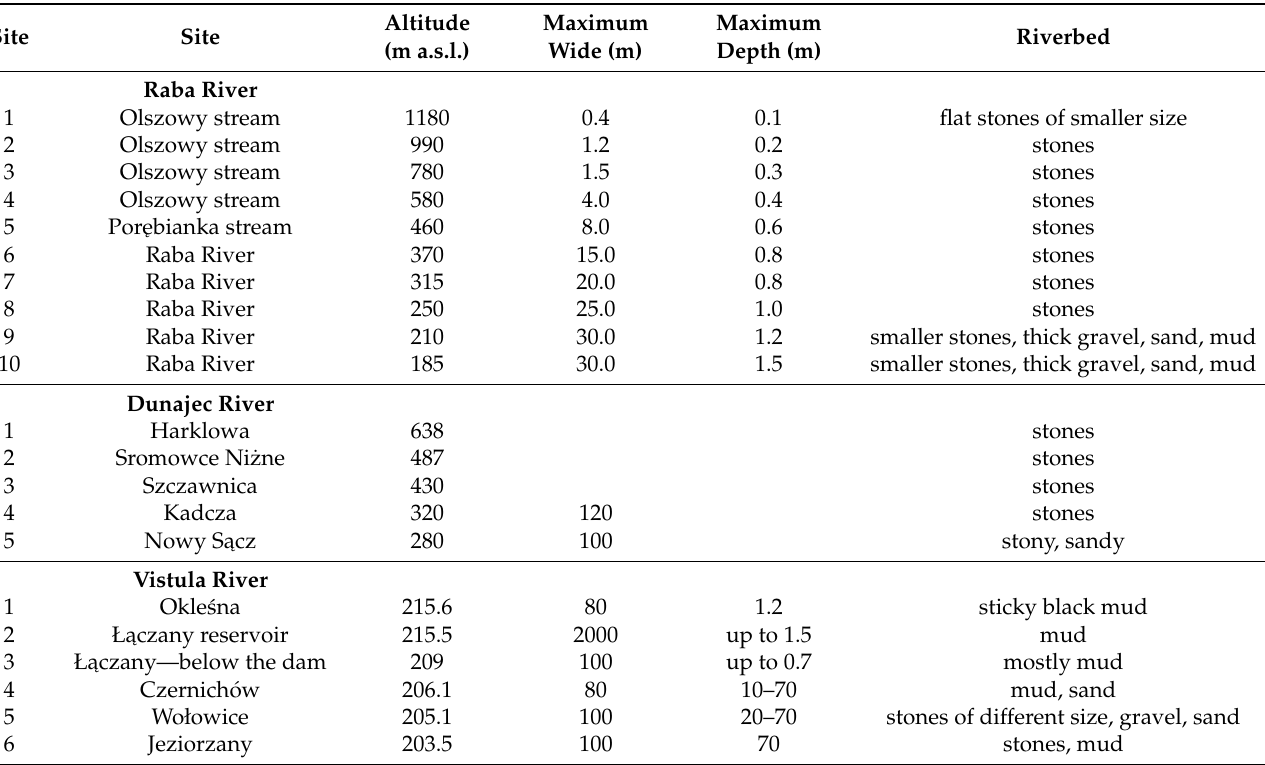
Table 1. Description of the sampling sites at Raba, Dunajec and Vistula rivers